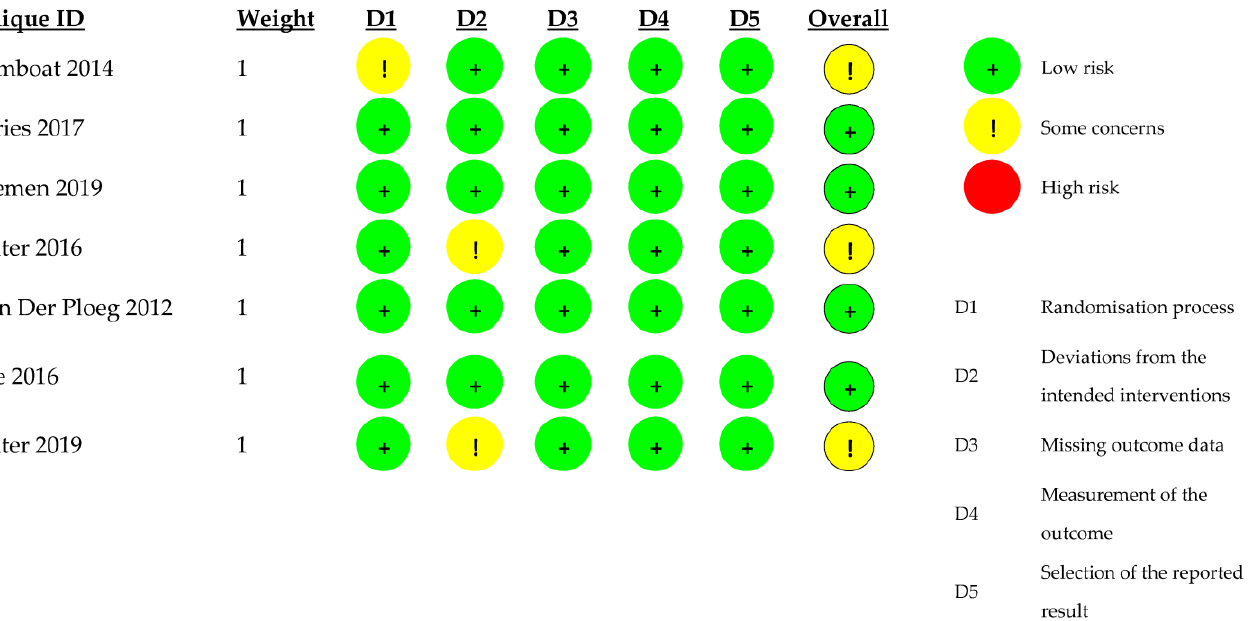
Figure 5. Quality assessment — Cochrane risk-of-bias tool for randomized trials (RoB 2) [3,4,28 – 32].